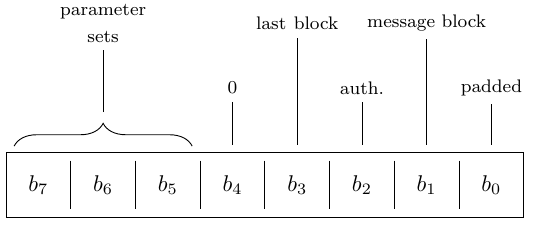
Figure 17: Domain separation when using the tweakable block